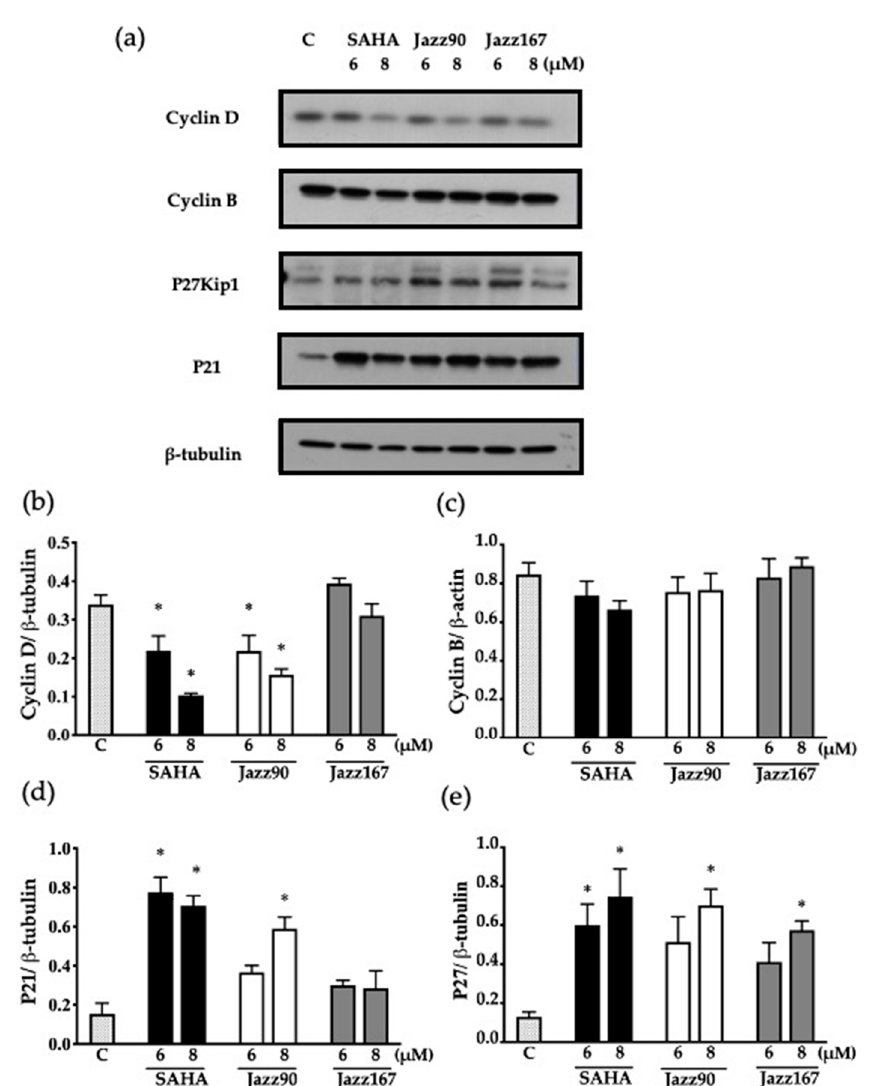
Figure 8. Cell cycle protein expression in PC3 cells. Cyclin D, cyclin B, p27kip1 and p21 levels were assessed in response to SAHA, Jazz90, and Jazz167 in PC3 cells at concentrations of 6 and 8 µM for 24 h. Vehicle control cells (C) were treated with 0.5% DMSO. Cell lysates were analyzed using Western blotting and β -tubulin was used as the loading control. ( a ) Representative blots for each of the proteins. Scanning densitometry graphs for ( b ) cyclin D, ( c ) cyclin B, ( d ) p21, and ( e ) p27kip1 are depicted. Bars represent the means ± S.E.M. from three independent experiments. Data were analyzed using a one-way ANOVA coupled with Bonferroni’s post hoc test; * indicates significant differences relative to the control, p < 0.05.